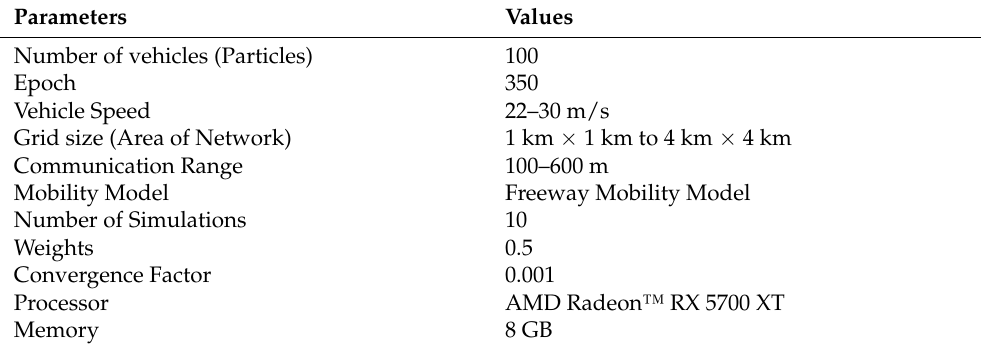
Table 1. Simulation